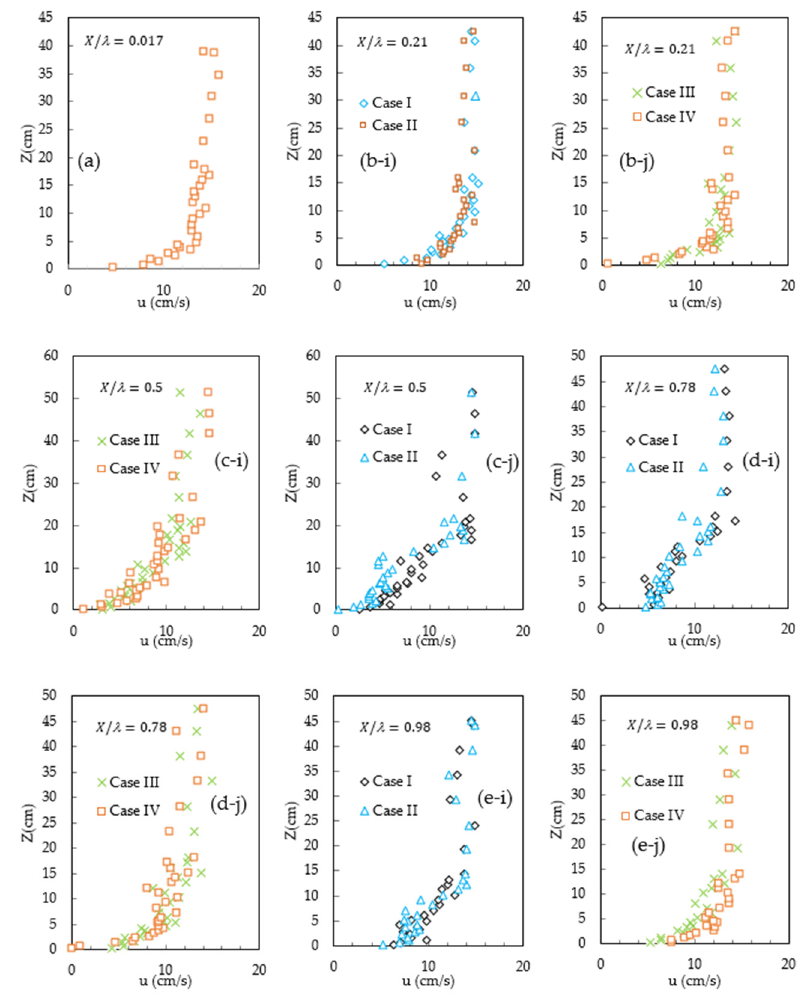
Figure 4. Profiles of streamwise velocity along the channel centerline for all Cases. ( a ) The upstream section of the pool ( X/ λ = 0.017 ), ( b-i , b-j ) the pool entrance ( X/ λ = 0.21 ), ( c-i , c-j ) the middle of the pool ( X/ λ = 0.5 ), ( d-i , d-j ) the pool exit ( X/ λ = 0.78 ), and ( e-i , e-j ) the downstream section of the pool ( X/ λ = 0.98 ).